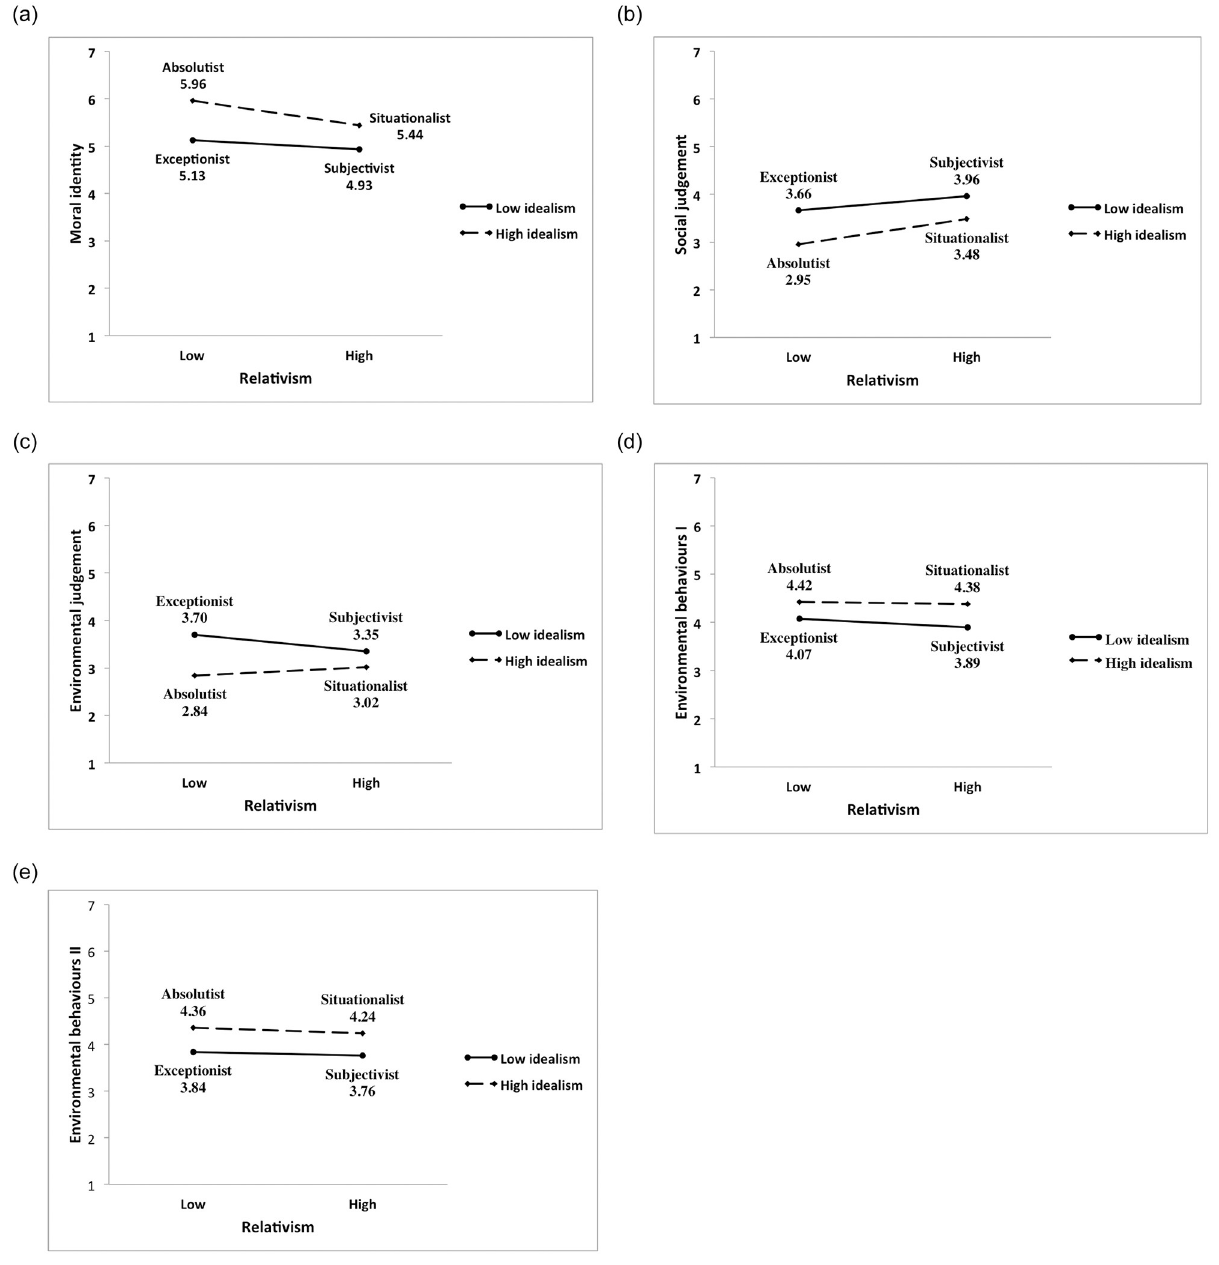
Fig 2. Mean scores of moral identity (2A), social judgement (2B), environmental judgement (2C), environmental behaviours I (2D) and II (2E) classified per to ethics position type.